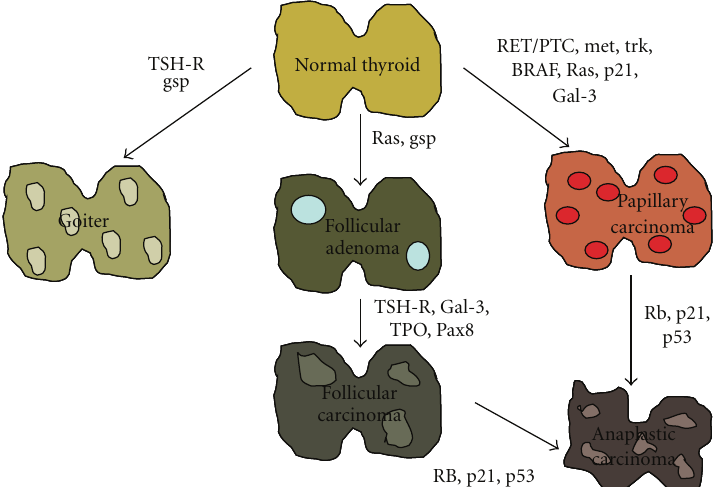
Figure 2: Multistep carcinogenesis model of thyroid cancer formation. Formation of benign thyroid tumors occurs as a result of alteration of various growth factors. Follicular neoplasms are formed from thyrocytes by mutations of RAS and other factors, as shown in the figure. Papillary cancers are formed by alterations in RET/PTC and other oncogenes. Undi ff erentiated tumors are formed from di ff erentiated tumors by mutations of tumor suppressor genes (adapted from